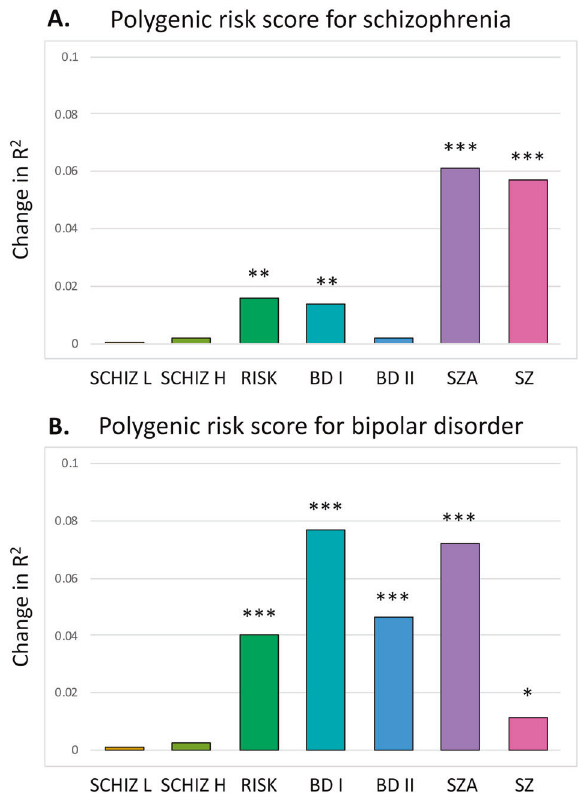
Fig. 2 Block-wise binary logistic regressions using polygenic risk score (PRS) in the case – control comparisons. A Polygenic risk score for schizophrenia. B Polygenic risk score for bipolar disorder. Asterisks indicate statistically signi fi cant effects of the full (covariates only) versus baseline (covariates with PRS) models: * p < 0.05; ** p < 0.01; *** p < 0.001. Group abbreviations: BD I bipolar I disorder, BD II bipolar II disorder, CTRL controls, RISK at-risk state for psychosis, SCHIZ H higher schizotypy, SCHIZ L lower schizotypy, SZA schizoaffective disorder, SZ